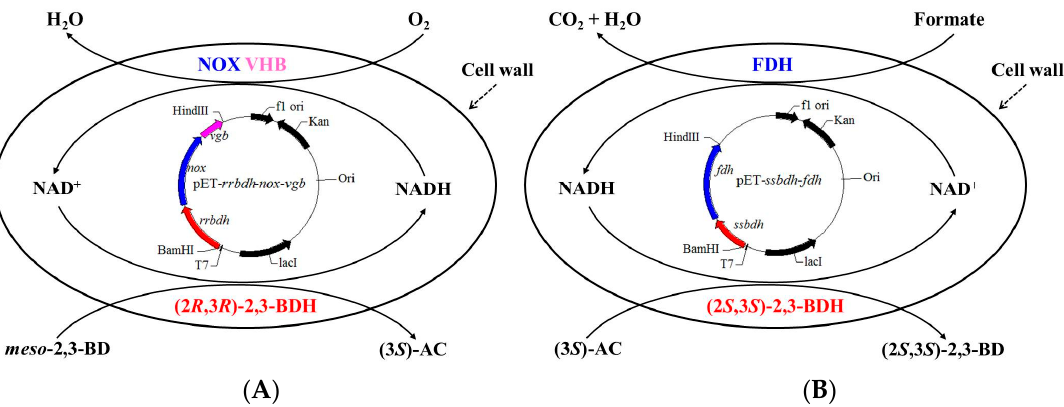
Figure 1. Schematic illustration of biocatalytic (3 S )-AC ( A ) and (2 S ,3 S )-2,3-BD ( B ) production from meso -2,3-BD using whole-cell biocatalysts of induced E. coli (pET- rrbdh - nox - vgb ) cells and induced E. coli (pET- ssbdh - fdh ) cells.